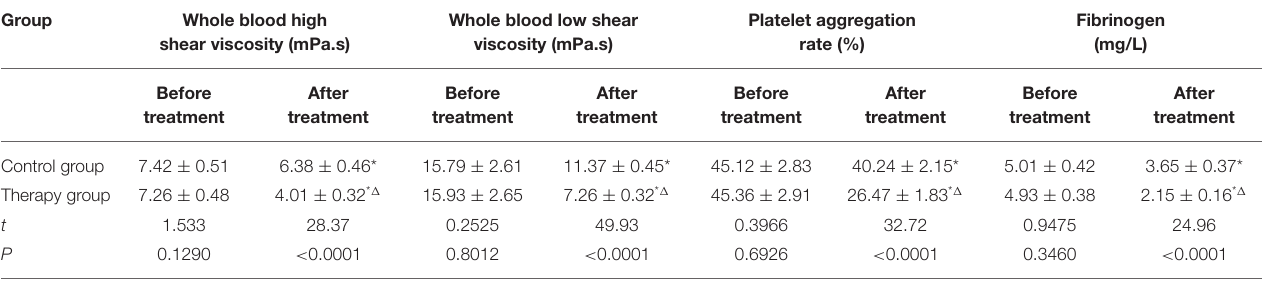
TABLE 5 | Comparison of whole blood high shear viscosity, whole blood low shear viscosity, platelet aggregation rate and fibrinogen index before and after treatment in the two groups (M ± S D, n = 45). Group Whole blood high Whole blood low shear Platelet aggregation shear viscosity (mPa.s) viscosity (mPa.s) rate (%) Before After Before After Before After Before After treatment treatment treatment treatment treatment treatment treatment treatment